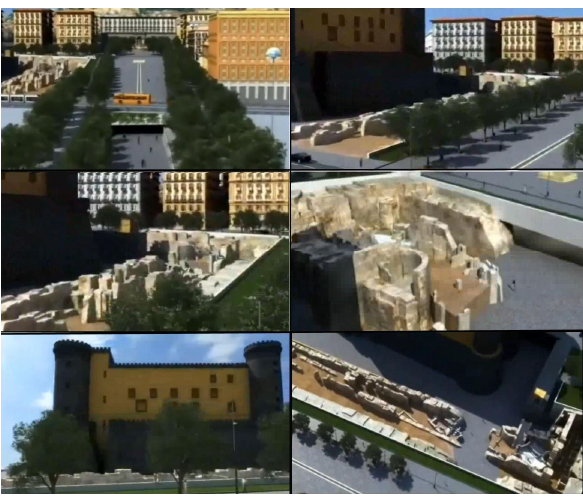
Figure 14: Piazza Municipio, virtual simulation of the project by Alvaro